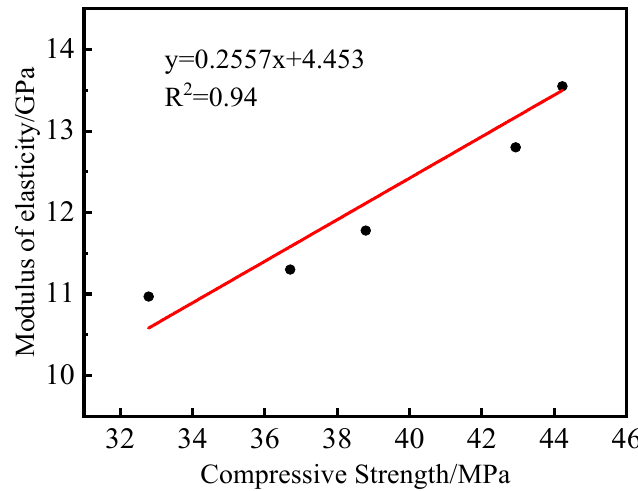
Figure 8. Linear fit of elastic modulus to compressive strength.